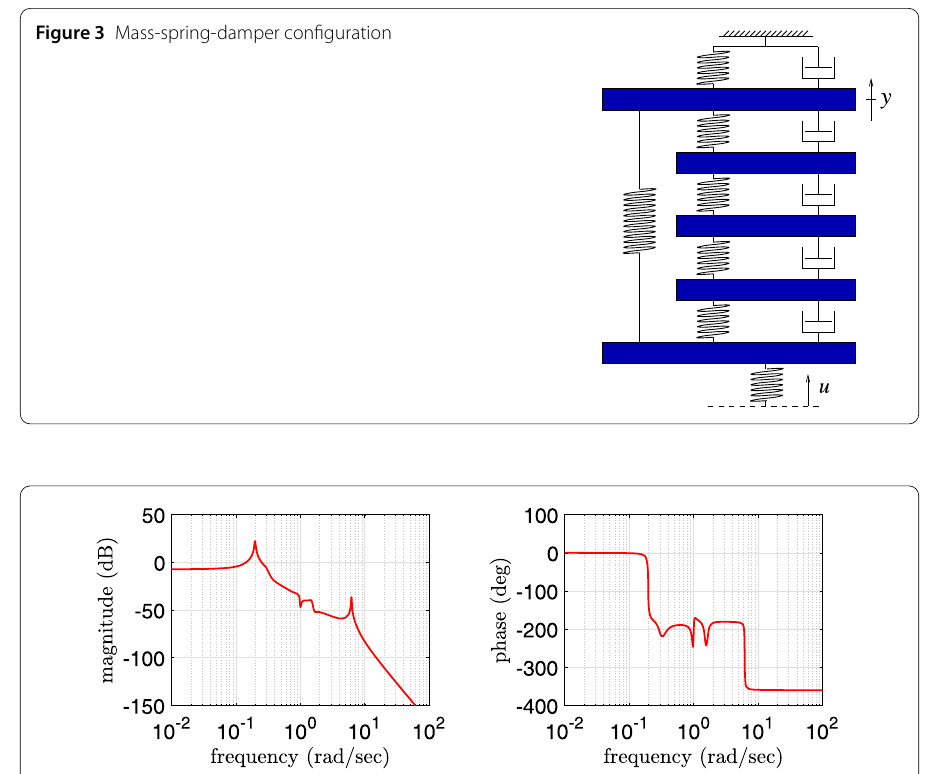
Figure 4 Bode plot of mass-spring-damper system for a constant choice of the parameters